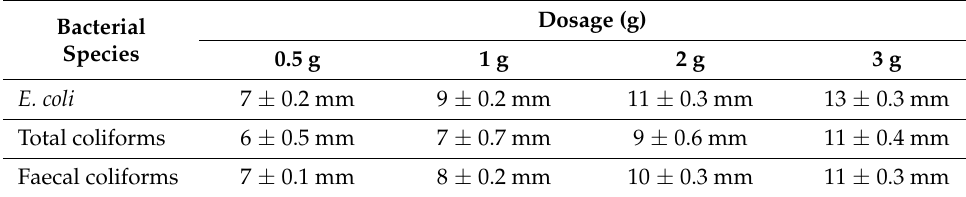
Table 4. Activities of sunflower seed extracts against bacterial species. Dosage (g) Bacterial Species 0.5 g 1 g 2 g 3 g E. coli 7 ± 0.2 mm 9 ± 0.2 mm Total coliforms 6 ± 0.5 mm 7 ± 0.7 mm Faecal coliforms 7 ± 0.1 mm 8 ± 0.2